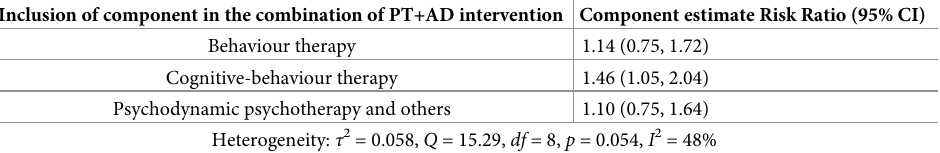
Behaviour therapy , Cognitive-behaviour therapy , and Psychodynamic psychotherapy , and others are entered as regressors in meta-regression analysis. The R package meta [41] was used with the risk ratio as the effect measure. Heterogeneity was estimated with the DerSimonian-Laird estimation